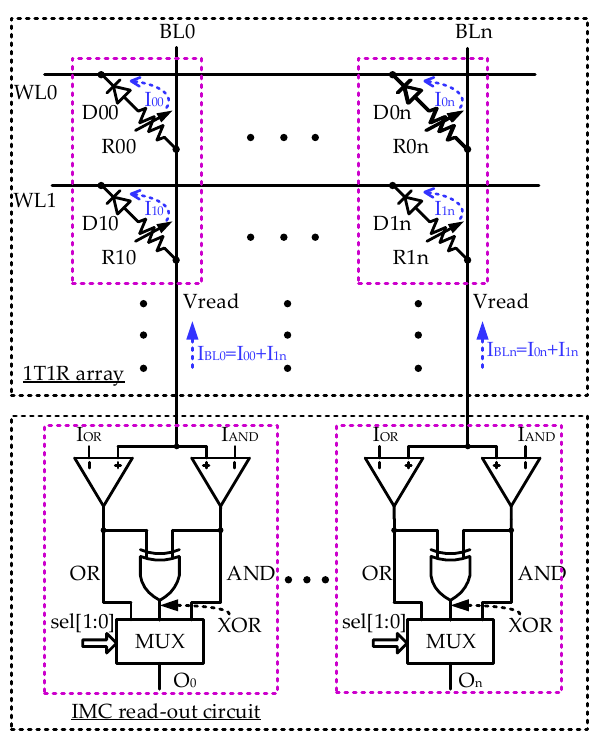
Figure 4. Memristor array with IMC read-out circuit. Table 4. Operation table of one-diode-one-memristor (1D1R) memristor array for IMC. HRS — high- resistance state; LRS — low-resistance state.